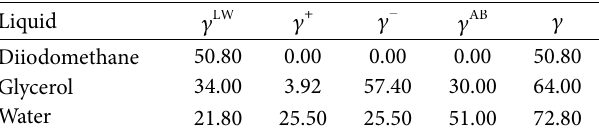
Table 1: Surface tension and components (mN/m) of three model liquids [44].